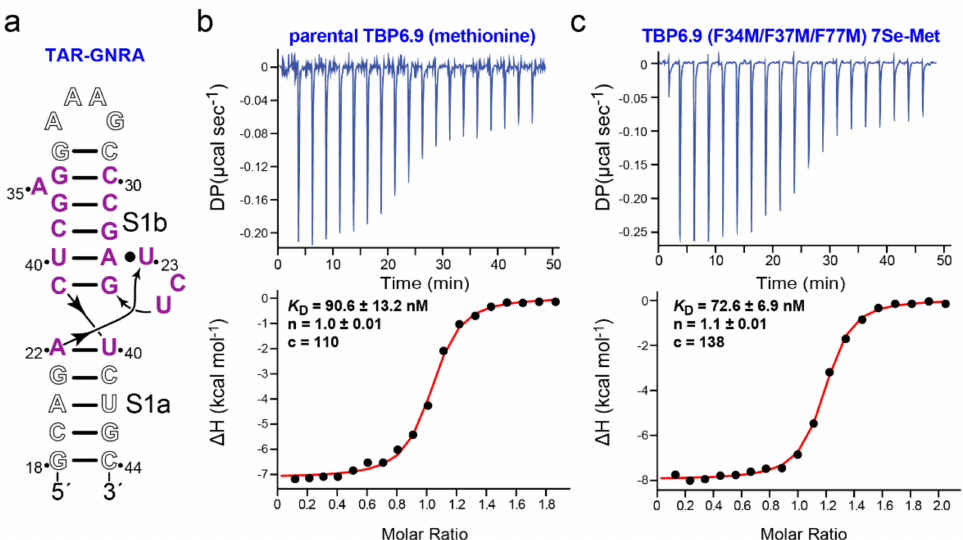
Figure 4. Schematic diagram of the TAR core binding motif for TBP and thermograms of TAR-GNRA binding to TBP6.9 and TBP6.9(F34M/F37M/F77M). ( a ) The TAR internal bulged loop (purple) de- picting regions that are non-essential for binding (white) based on the crystal structure and binding experiments [51,52]. The apical loop was substituted with a GAAA tetraloop and a closing C–G pair, which produces optimal thermodynamic stability for this motif [89]. ( b ) Thermogram of GNRA- TAR RNA binding to the parental TAR TBP6.9 prepared without selenomethionine substitution. Here and elsewhere the average thermodynamic parameters are reported in Table 2. ( c ) Ther- mogram of GNRA-TAR RNA binding to TBP6.9(F34M/F37M/F77M) prepared in the presence of